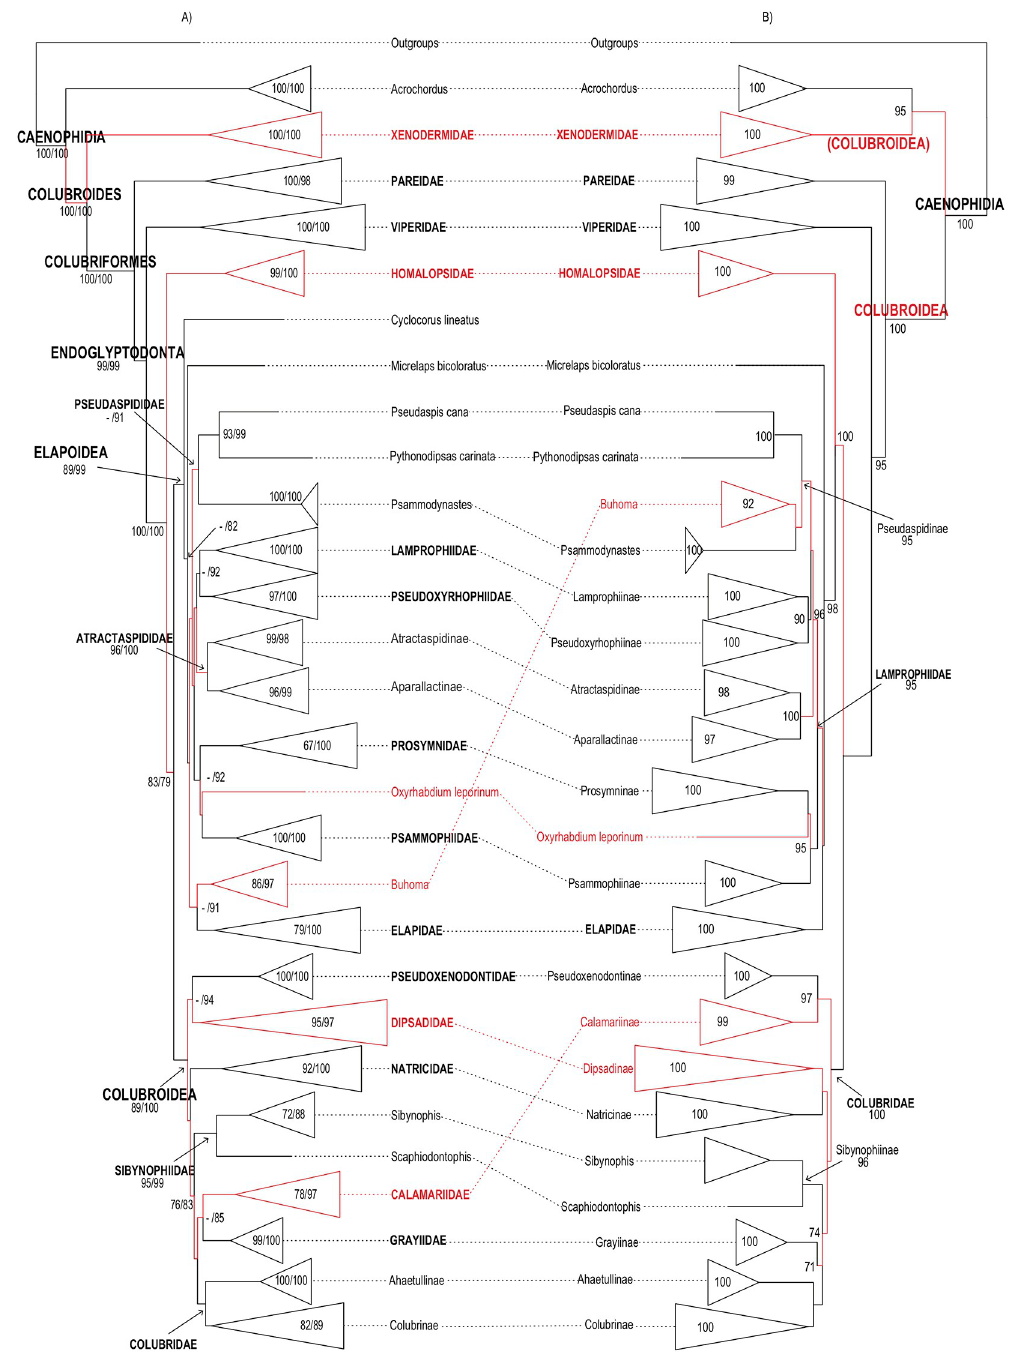
Fig 2. Higher-level caenophidian phylogenies. Comparison between Maximum-likelihood phylogenetic estimates from (A) the present study and (B) Pyron et al. [26]. Tips represent commonly recognized families, subfamilies and rogue taxa. Names in red correspond to taxa with distinct phylogenetic positions in the topologies compared. Numbers on each branch and within expanded tips correspond to our and previously reported support values: (A) FBP (left) and SHL (right); (B) SHL. Branches without numbers have support <